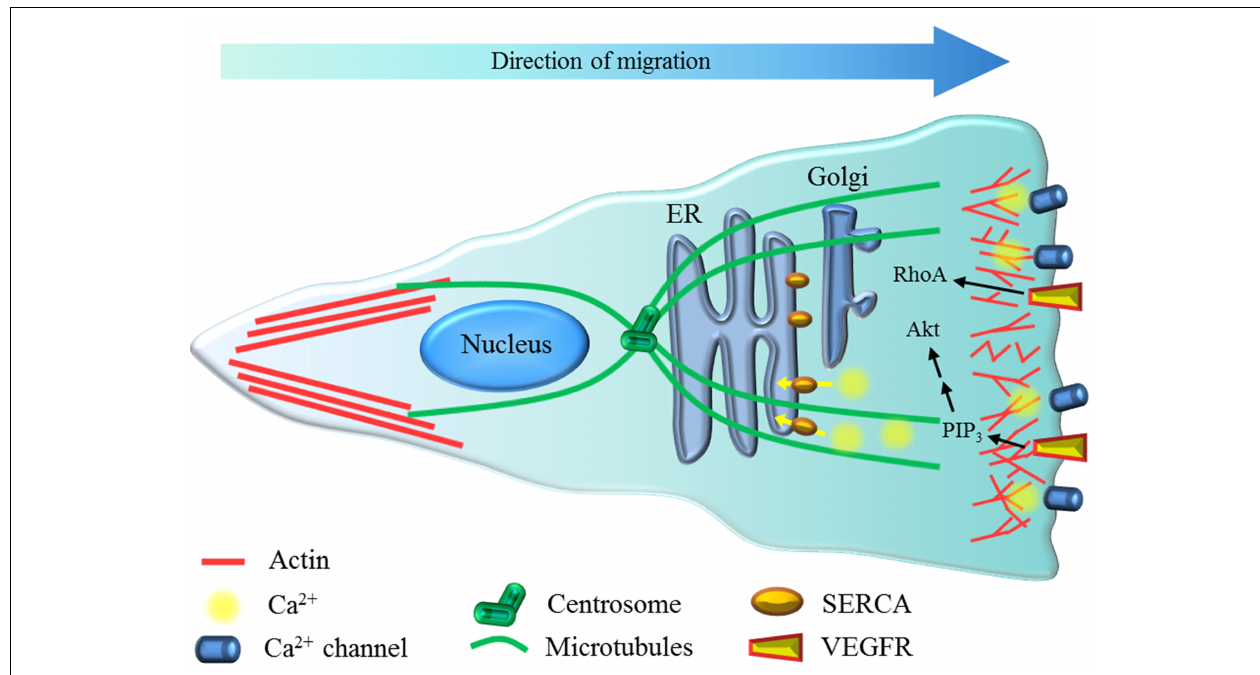
FIGURE 1 | Possible role of ER stress on EC migration. Migrating EC have actin (red) dynamics at the front and also polarization of the centrosome and microtubules (green) and Golgi apparatus toward the leading edge. Ca 2 + (yellow) dynamics at the front of the cell are mainly mediated by Ca 2 + channels (i.e., Orai), and the sarco/endoplasmic reticulum Ca 2 + -ATPase pump (SERCA, orange) restores the free